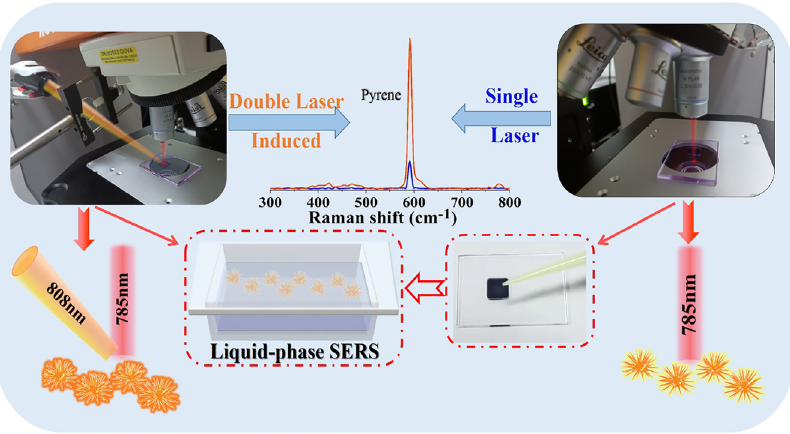
Figure 1: The schematic diagram of double laser beam-excited equipment for further boosting liquid-NIR-SERS enhancement of non-adsorptive toxic PAHs